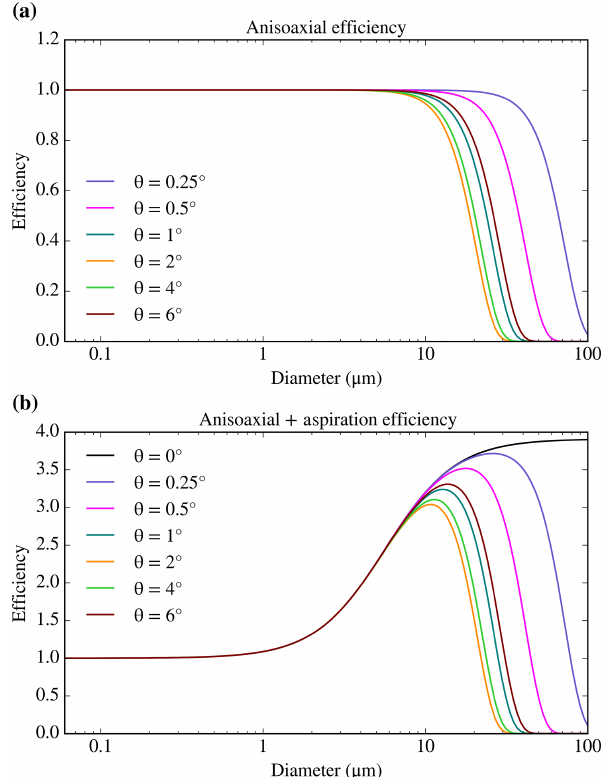
Figure 3. Anisoaxial inertial losses of the sampling carried out by the filter inlet system for different values of the angle in between the inlet and the flight direction. The calculations have been pre- sented by themselves (a) and combined with the aspiration effi- ciency (b) , which one can see in Fig. 2a. The anisoaxial calcula- tions have been carried out using the equations given by Hangal and Willeke (1990b), using the same parameters and dimensions as in Fig. 2, apart from the flow rate, which was set to 65Lmin − 1 in order to be within the valid range of U/U 0 that was used to develop the equation. For smaller or larger values of the flow rate (under which most of the sampling is carried out), the differences in the efficiency from the ones shown here are